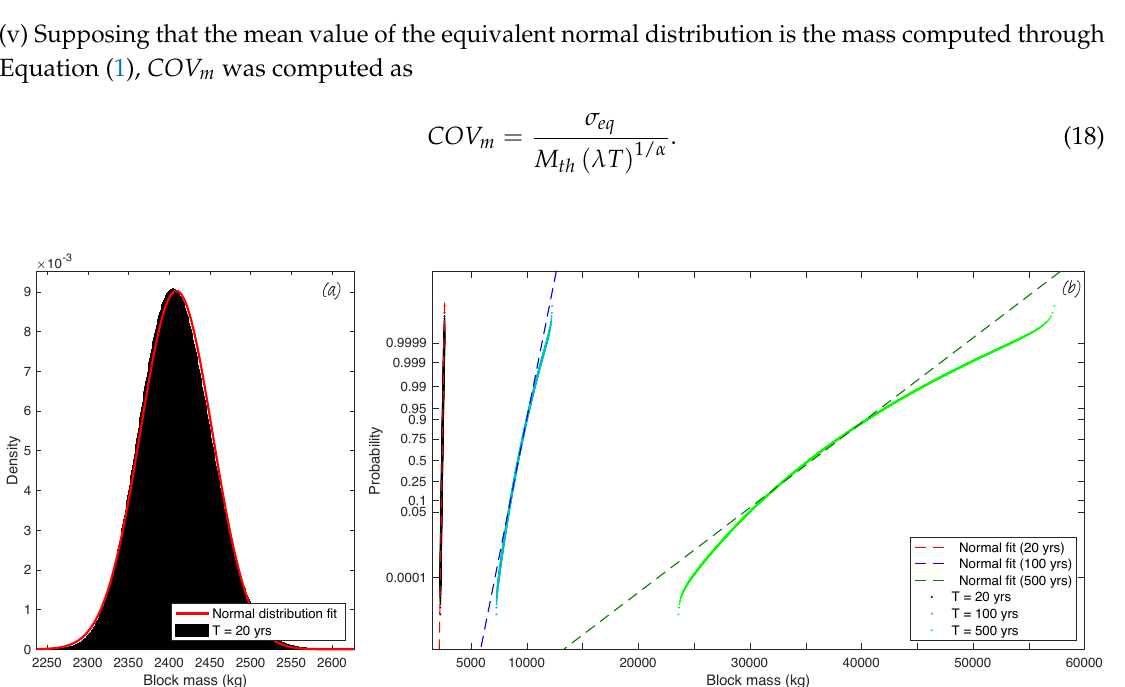
Figure 3. In ( a ): distribution of the volume at 20 years return period and normal distribution fit. In ( b ): normal probabilityplotwiththedistributionsofthevolumescorrespondingtothreereturnperiods(20years, 100years and 500 years). The simulations were performed with α = 1.2, λ = 0.1 events/yr, N = 1000, M th = 1350 kg. Normally distributed data are identified with a straight line in the probability plot.